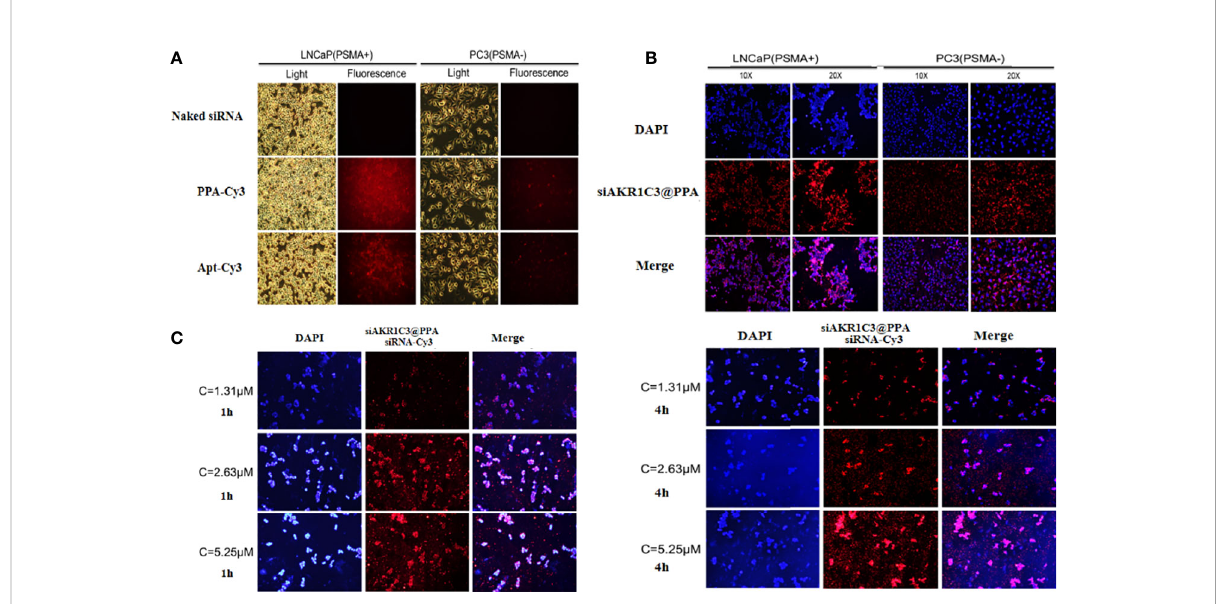
FIGURE 3 siAKR1C3@PPA can target prostate cancer cells (PSMA + ). (A) Localization of PPA and aptamer in LNCaP and PC3 cells for 4 h at 37°C. Cy3- labeled aptamer. (B) Localization of siAKR1C3@PPA in LNCaP and PC3 cells for 4 h at 37°C. Cy3-labeled siRNA. (C) The degree of siAKR1C3@PPA internalization is dose- and time dependent. Cy3-labeled